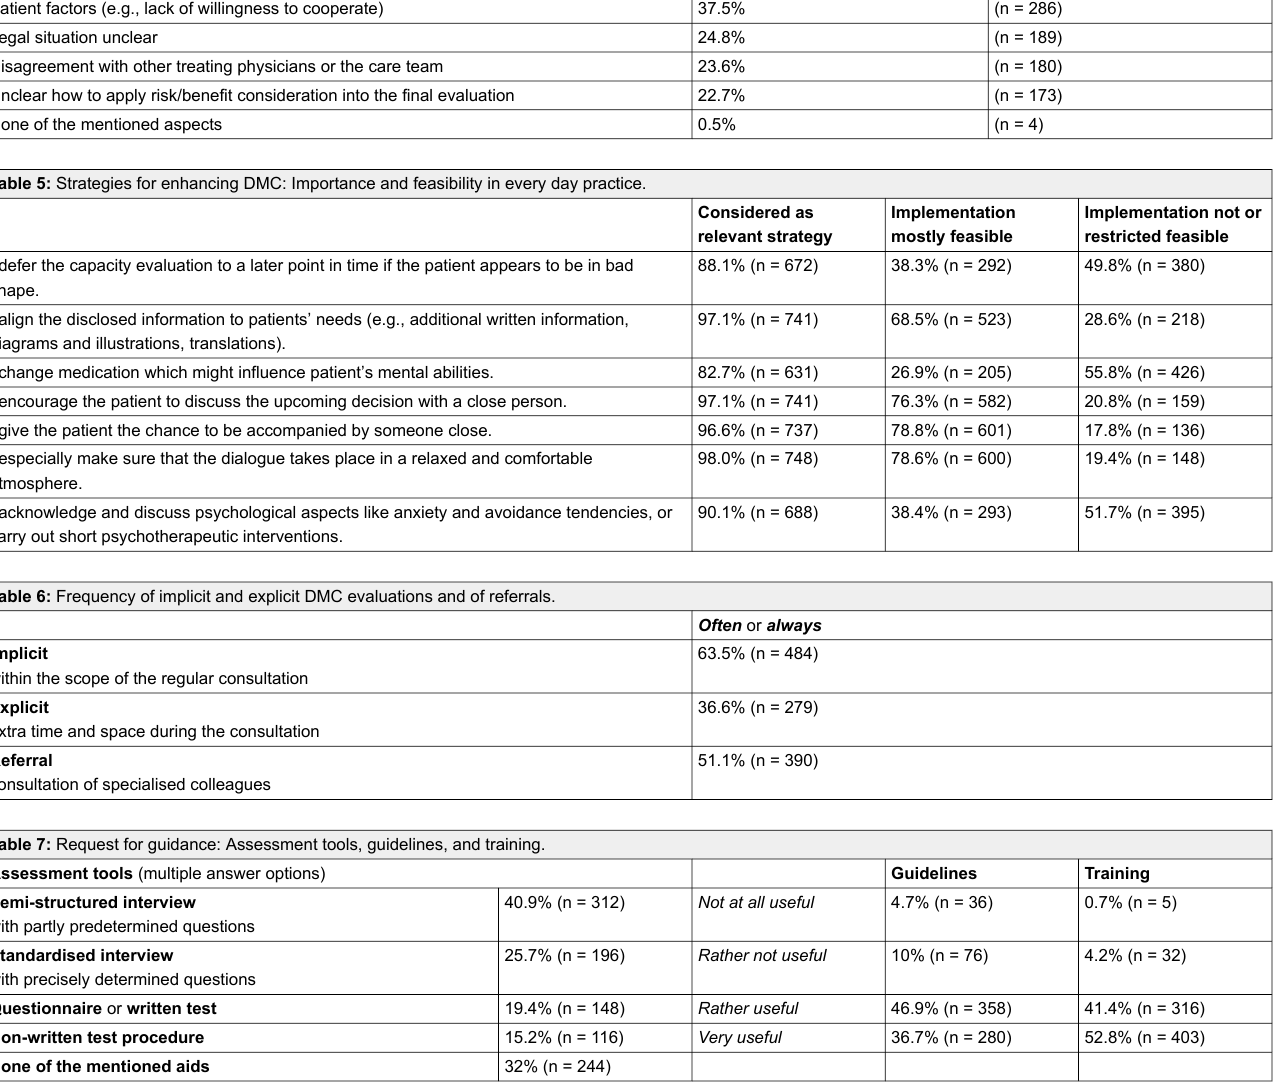
Table 7: Request for guidance: Assessment tools, guidelines, and